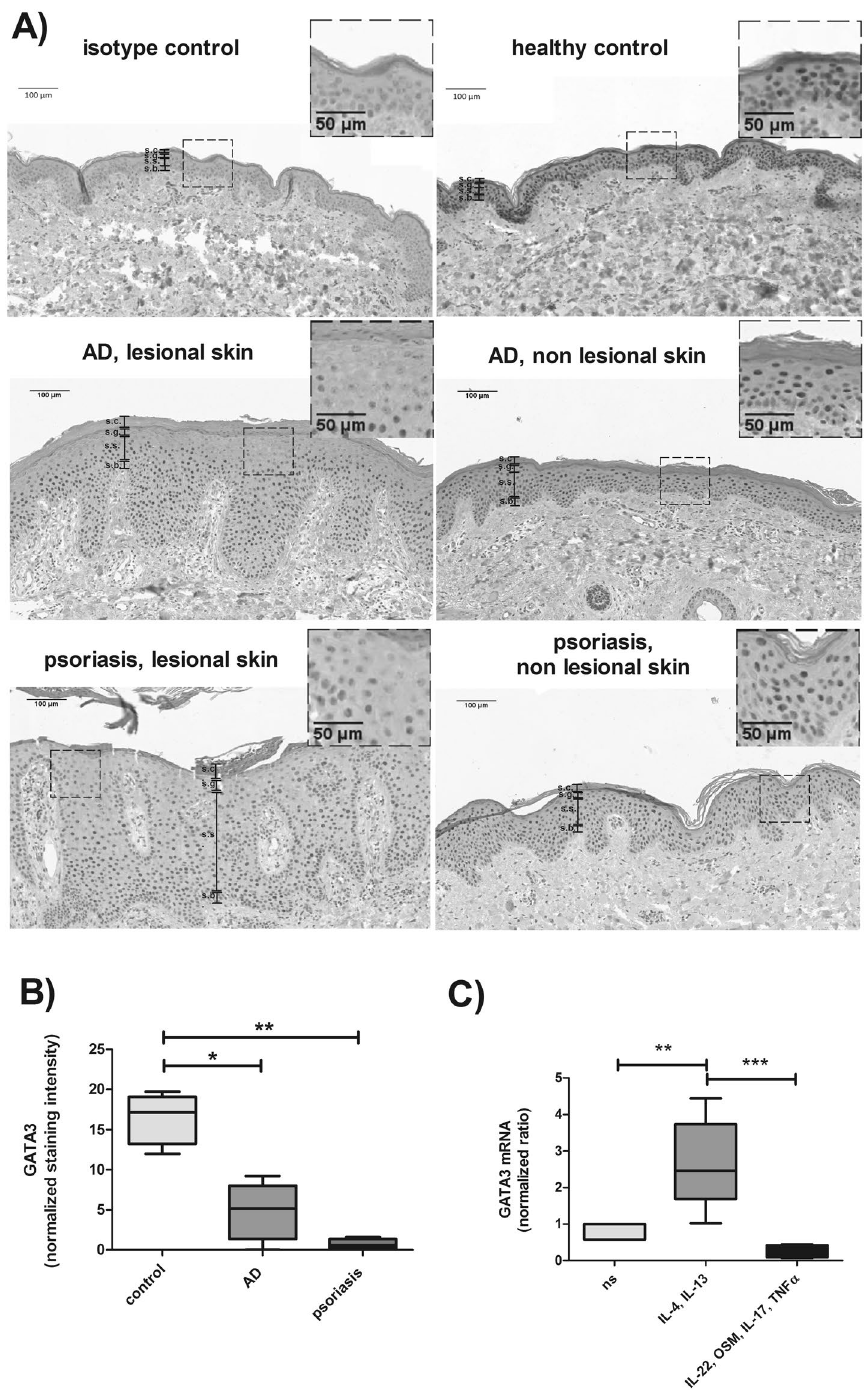
Figure 1. GATA3 expression profiles in skin from patients suffering from AD or psoriasis compared to healthy controls. ( A ) Skin biopsies from lesional and non-lesional skin as well as skin from healthy controls were stained for the expression of GATA3 by immunohistochemistry. A representative example of lesional and non-lesional skin (same donor) of AD and psoriasis as well as from a healthy control is depicted (psoriasis n = 4 (lesional and non-lesional skin), AD n = 3 (lesional and non-lesional skin) and 3 additional lesional AD samples were analysed). s.c. = stratum corneum, s.g. = stratum granulosum, s.s. = stratum spinosum, s.b. = stratum basale. ( B ) The intensity of the immunohistochemical staining of GATA3 in the three uppermost cell layers located in the stratum granulosum and stratum spinosum was quantified by using the software cellSense Dimension with Count & Measure Solution (Olympus). Cell layers located in the stratum corneum were not included in the quantification. The normalized staining intensity of GATA3 in lesional AD, lesional psoriasis and in healthy controls is depicted (normalized to the area of the analysed region). ( C ) Quantitative RealTime PCR was performed on primary keratinocytes cultivated with the indicated cytokines for 24 h (25 ng/ml were